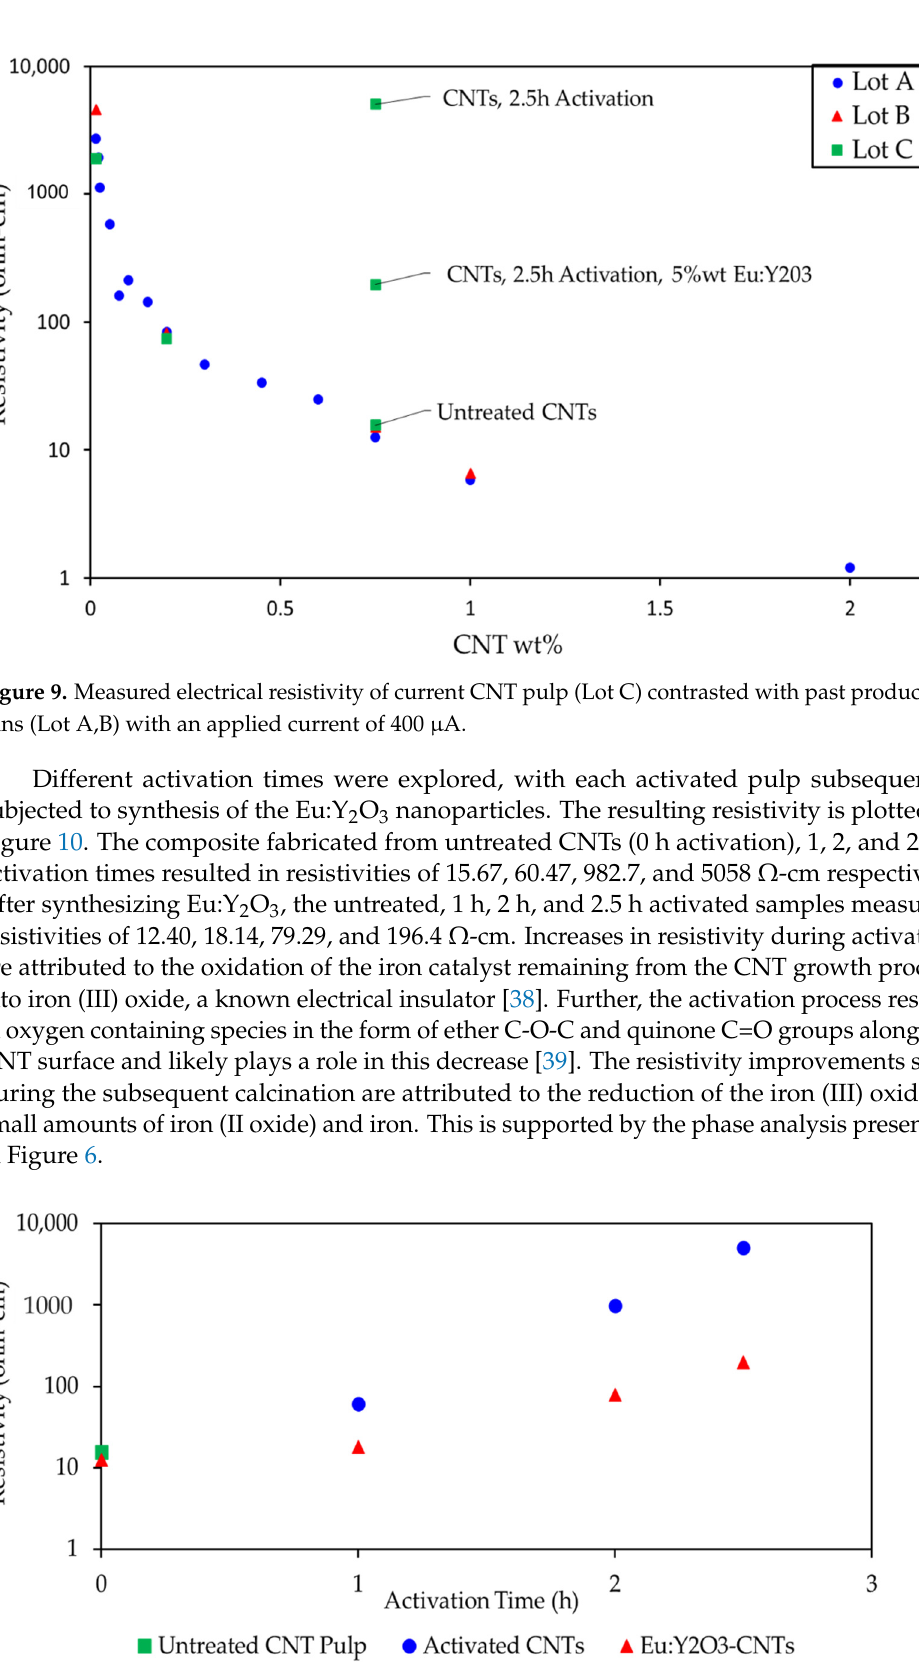
Figure 10. Effects of activation and inclusion of Eu:Y 2 O 3 particles on electrical resistivity on a nanocomposite samples with 0.75%wt CNT loading.